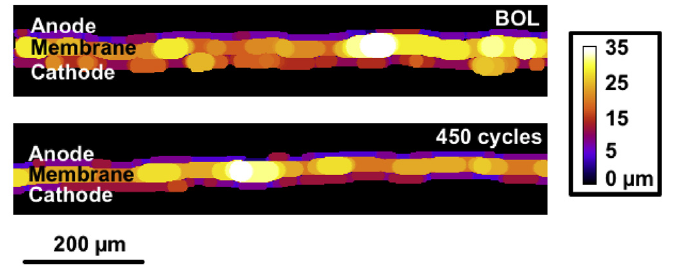
Figure 7. XCT-based cross-sectional views at different degradation stages. The thickness of CLs and membrane can be determined. Reprinted from the work in